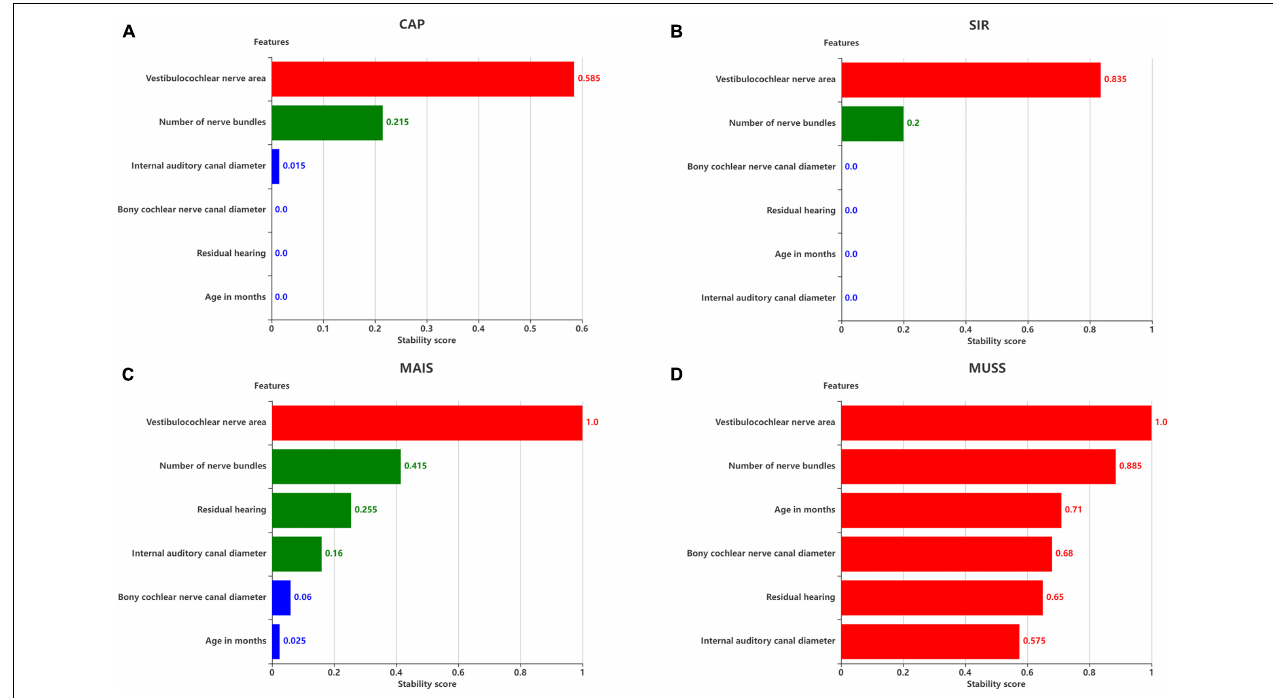
FIGURE 8 | Stability scores for feature selection. Effect of features on (A) SIR, (B) CAP, (C) MAIS, and (D) MUSS. The stability score in 0–1 is shown as range per bin.